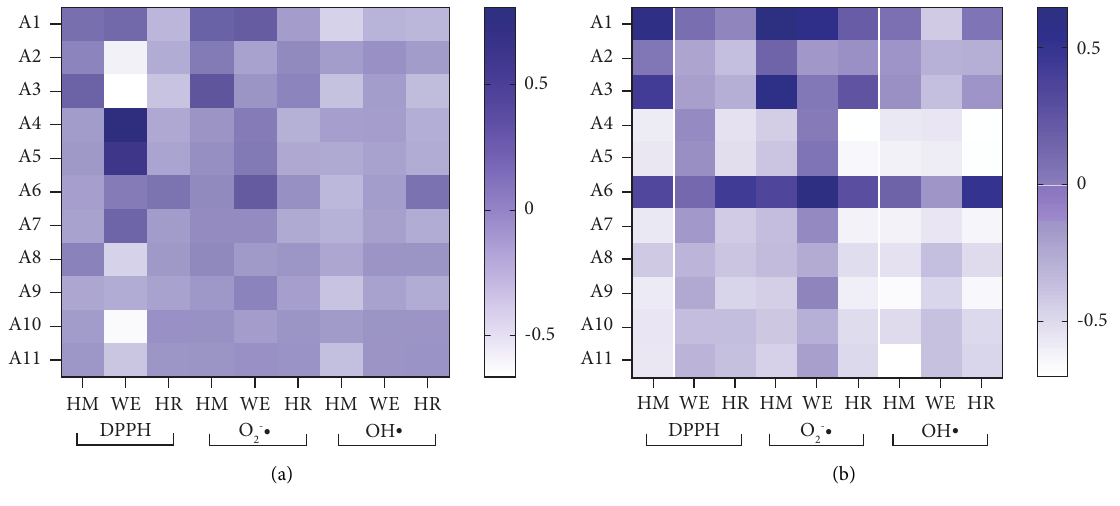
Figure 6: Heatmap diagrams: (a) PLSR model. (b) BCA